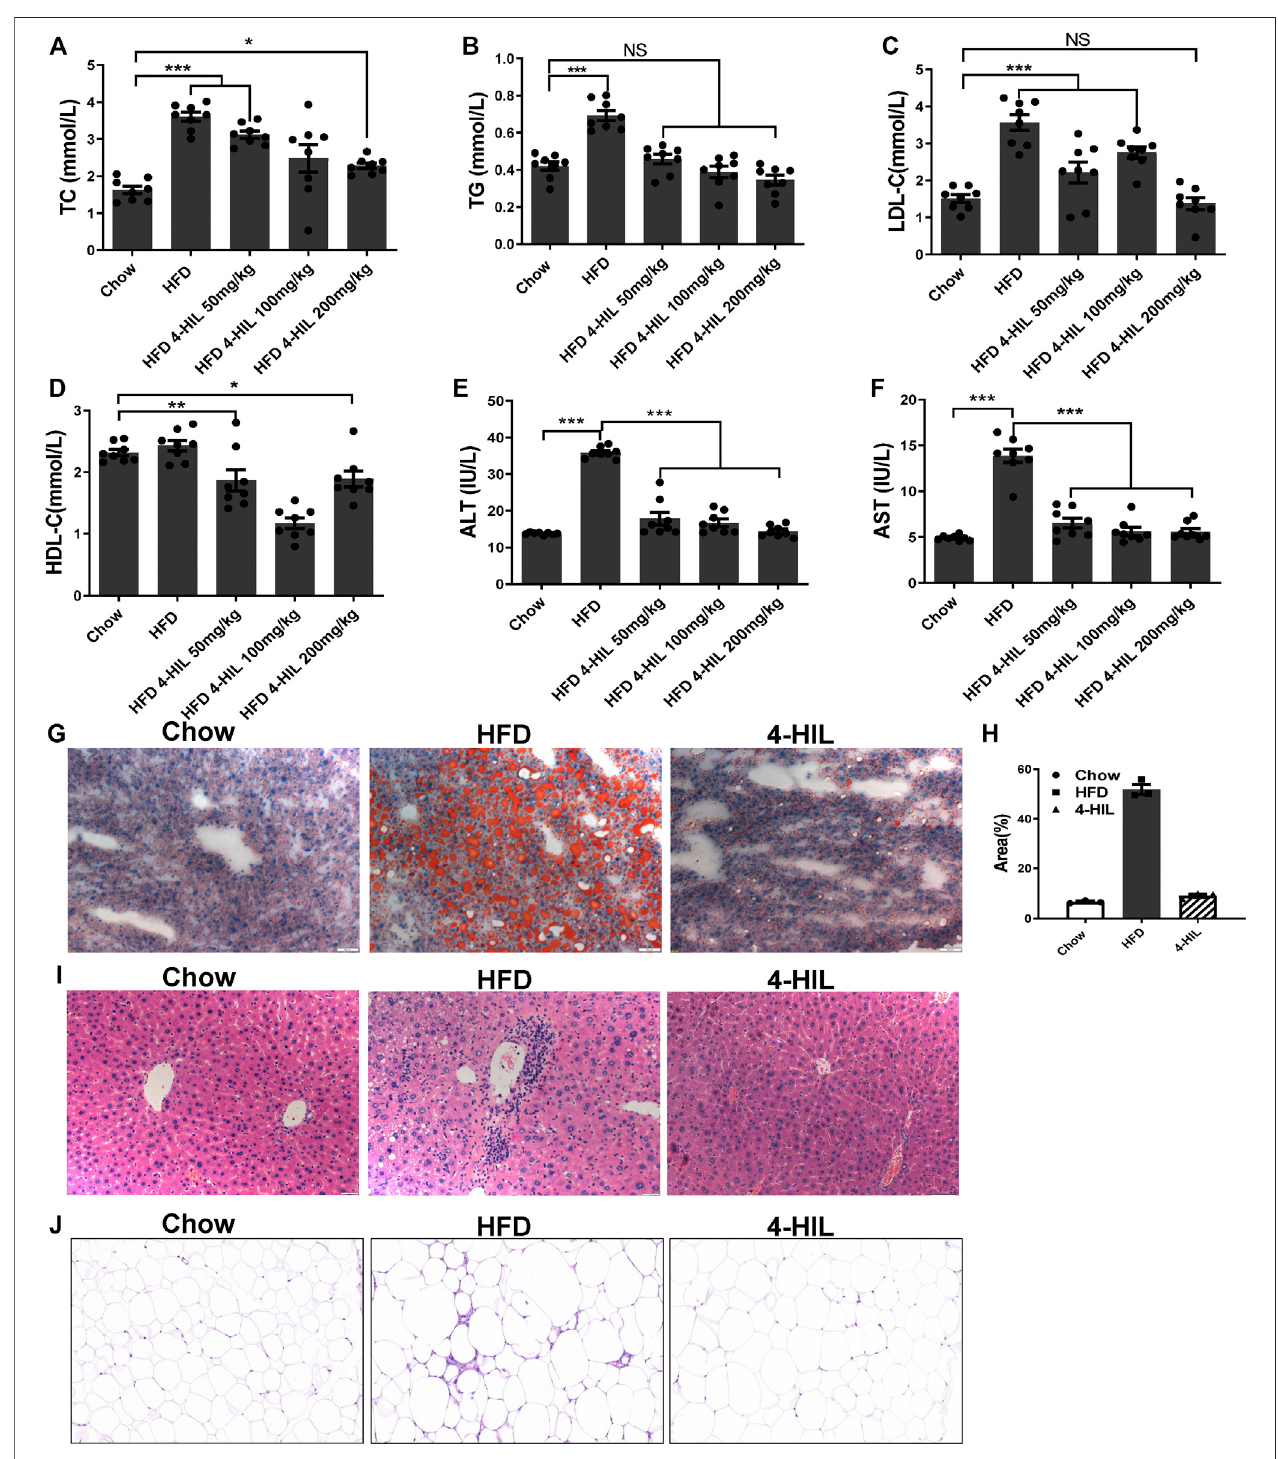
FIGURE3| 4-HILreducesdyslipidemia.After4-HILadministration,bloodsamplesweretakenfromtheorbitofmiceafterfastingfor8 h,andthecontentsofTC (A) , TG (B) , LDL-C (C) , HDL-C (D) , ALT (E) , and AST (F) in plasma were measured according to the instructions of the kits. Oil Red O staining of liver tissue (200 × ) (G) , HE staining of liver tissue (200 × ) (I) , and HE staining of adipose tissue (200 × ) (J) are presented. *, 0.01 < p < 0.05; **, 0.001 < p < 0.01; ***, p < 0.001 ( n (cid:2) 8 for each group).